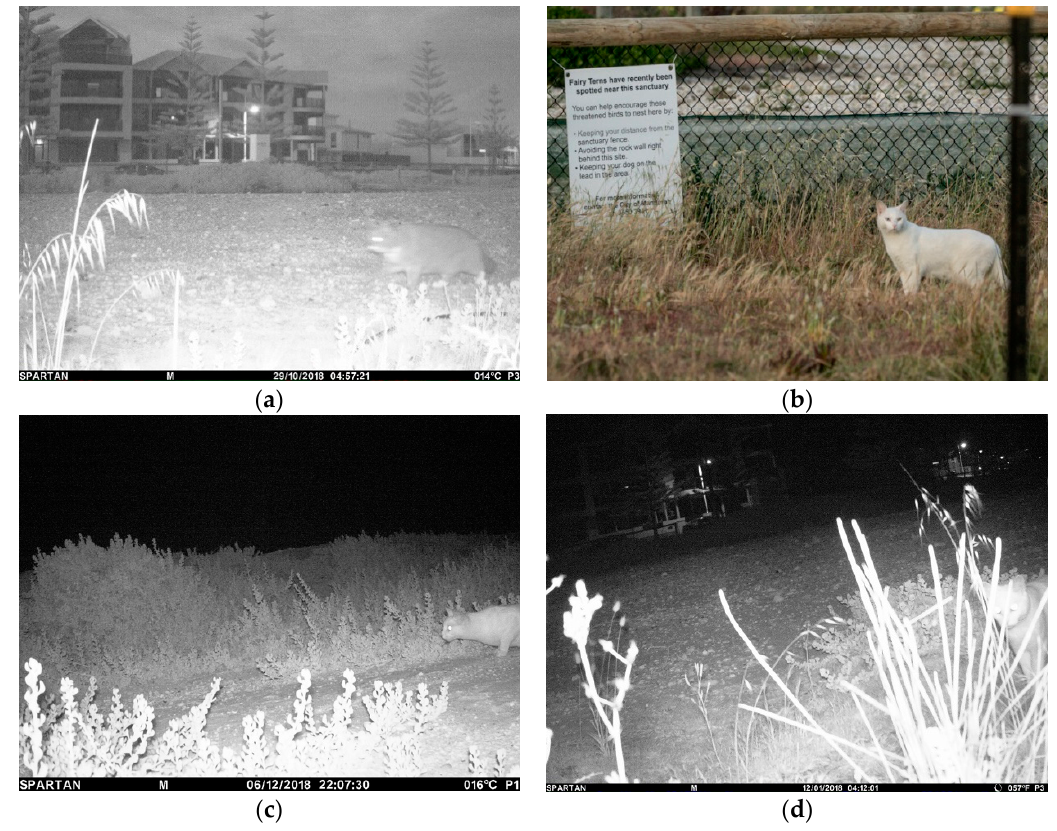
Figure 2. Photographs of a pet and semi-feral cat in and around the Fairy Tern Breakwater Parade sanctuary, taken by wildlife cameras (a, c, d, City of Mandurah, 2018) and a local resident (b, England, L., 2018). Table 2. Timeline showing colony development at the sanctuary in Mandurah, incursions by a pet and semi-feral cat, depredation events and management activities undertaken during the 2018 breeding season. The grey shading shows the period in which sunrise-to-sunset observations of the nesting colony were made .